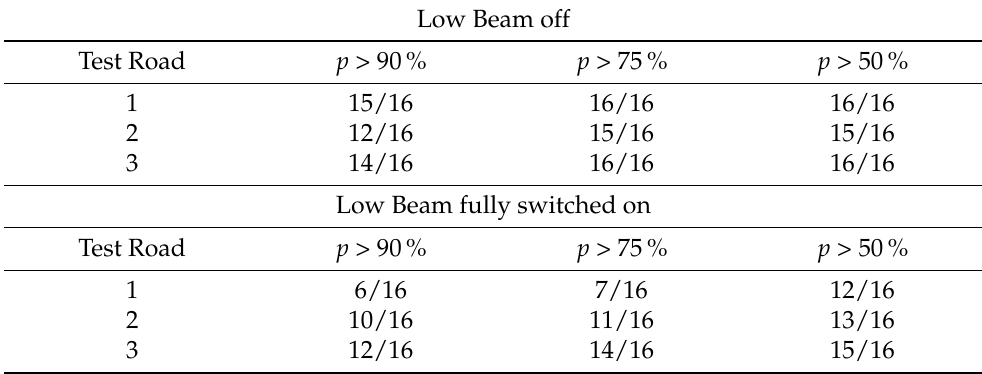
Table 8. Proportion of detected objects on vehicle position 1.